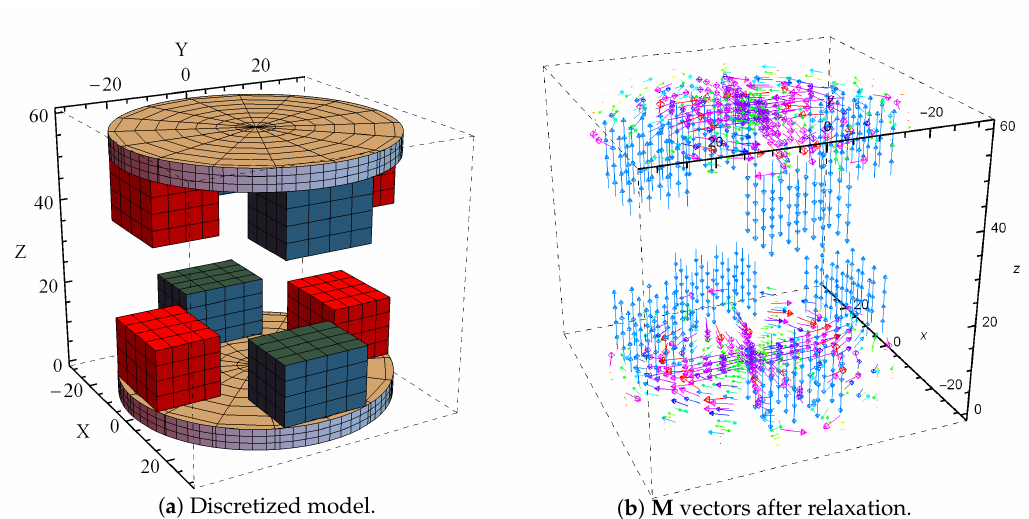
Figure 4. ( a ) Flat-RMCT model in the neutral configuration ( α = 0 ◦ ), represented on RADIA. ( b ) Magnetization M in each element after the relaxation